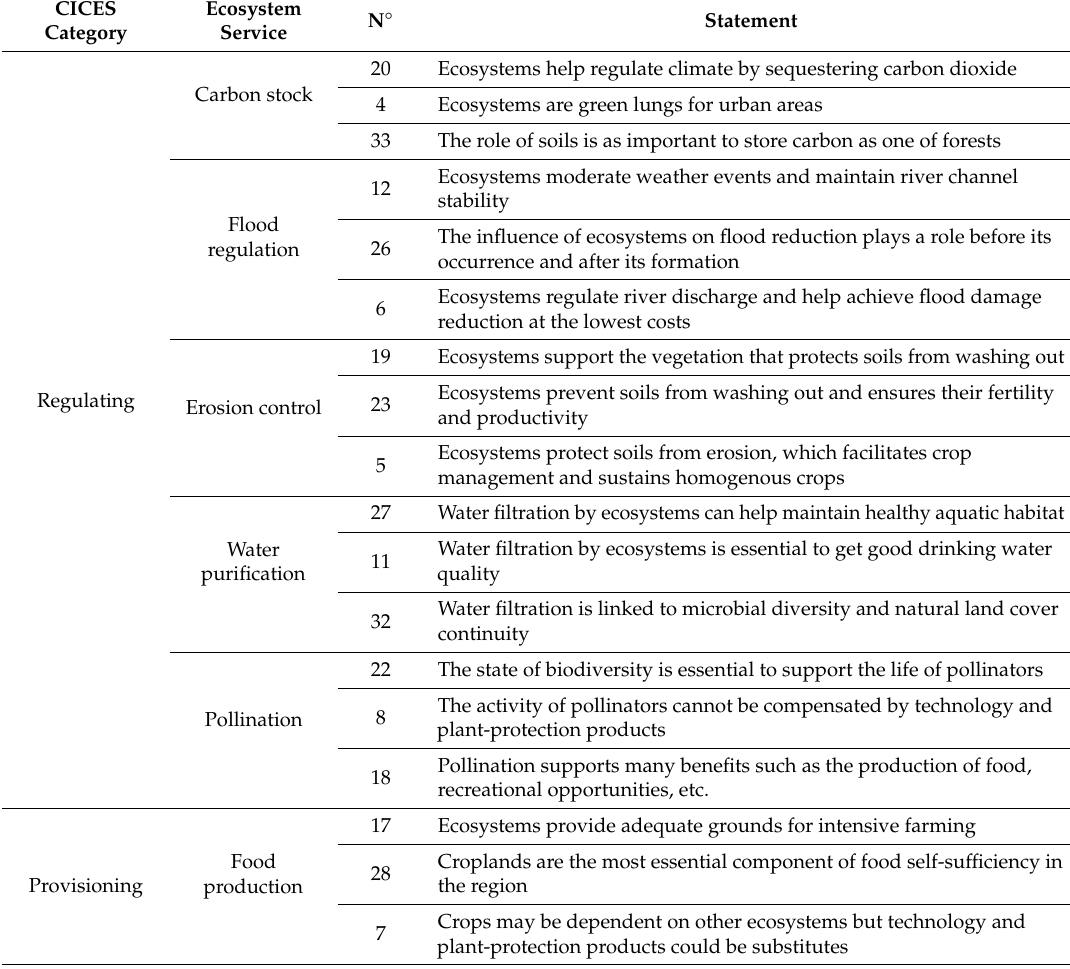
Table 1. Thirty-three Q-statements of ecosystem